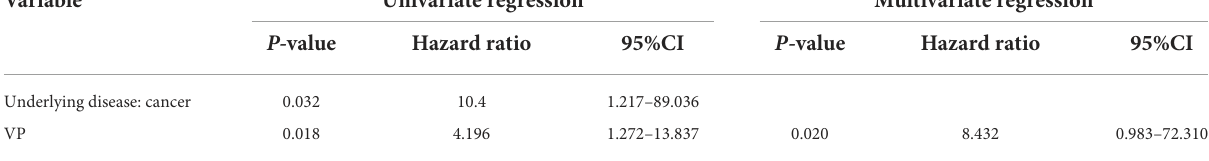
TABLE 4 Cox proportional hazards analysis for critical patients with cryptococcal meningitis. Variable Univariate regression Multivariate